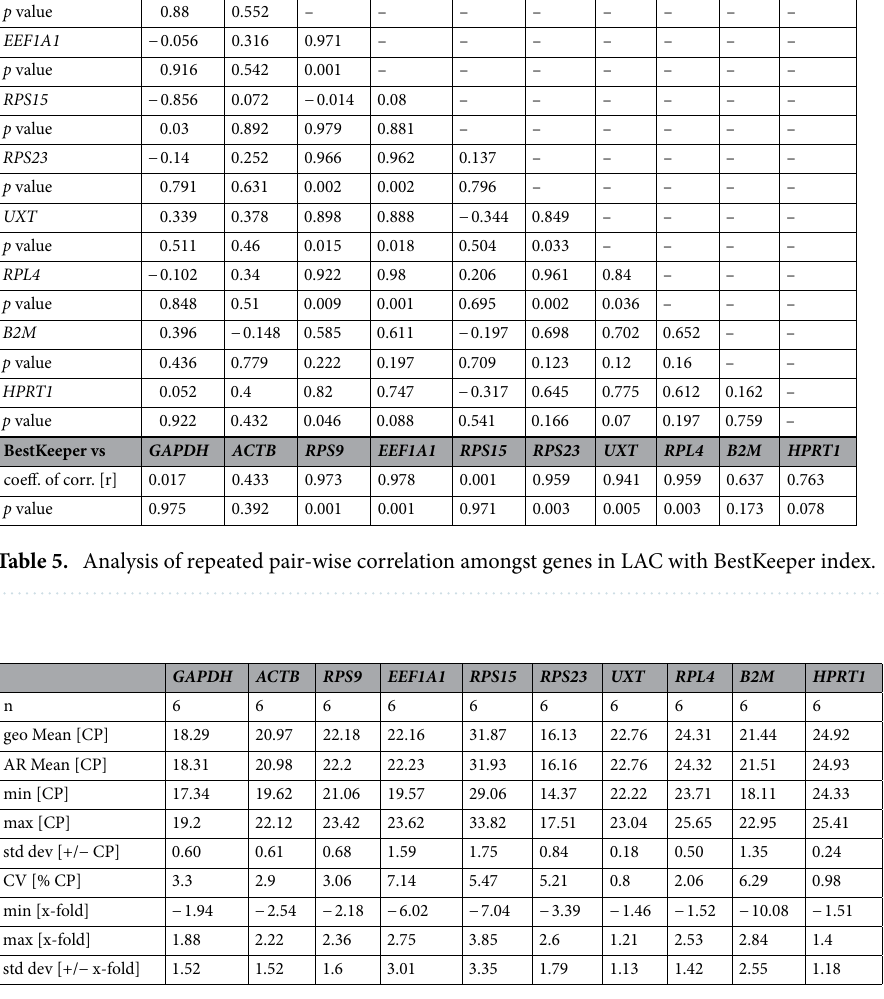
Overall, HPRT1, B2M and ACTB were identified as the most appropriate RGs in high altitude adapted DHC using all four algorithms. Zanskar Horses (ZAP). The M values calculated using geNorm analysis for all the RGs in Zanskar ponies are shown in Table 3. Except, B2M and GAPDH RGs, the M values for all other RGs were within the acceptable limit of < 1.5. The M value for all the RGs in ZAP ranged from 0.135 to 1.721. The ranking order of RGs was as follows; RPS9 = RPL4 > RPS23 > EEF1A1 > UXT > RPS15 > HPRT1 > ACTB > B2M > GAPDH (Fig. 2p). The two most stable RGs with lowest M value were RPS9 and RPL4 (0.135) while GAPDH and B2M were the least stable RGs with M value of 1.712 and 1.394 respectively. Further, the V values for V2/3, V3/4, V4/5 and V5/6 were within the threshold limit of 0.15. Based on geNorm analysis, the geometric mean of RPS9, RPL4 and RPS23 RGs is likely to provide accurate normalization of gene expression data in ZAP (Fig. 2q). In Normfinder analysis ranking of genes in high altitude ZAP from most stable to least stable was as follows: EEF1A1 (0.631), UXT (0.684), RPS9 (0.749), RPS23 (0.759), RPL4 (0.763), RPS15 (1.022), ACTB (1.36), HPRT1